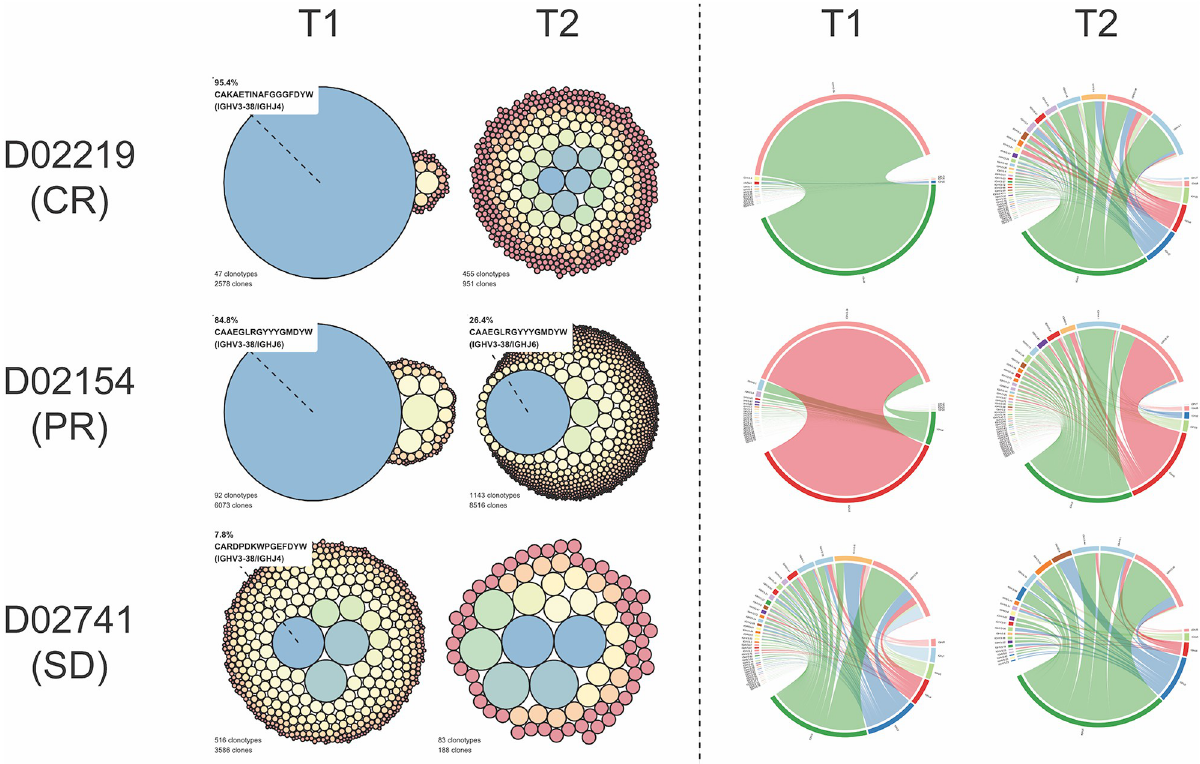
Fig 14. IGH clonality by clinical outcome. Circle size scaled to clonotype frequency (left) and VJ junction circos plots (right) at T1 and T2 for individual cases with complete remission (D02219), partial remission (D02154), and stable disease treated only with prednisone (D02741). Clonotype with highest frequency at T1 is labeled with CDR3 amino acid sequence and V and J genes. The same clonotype is labeled at T2 if identified within the